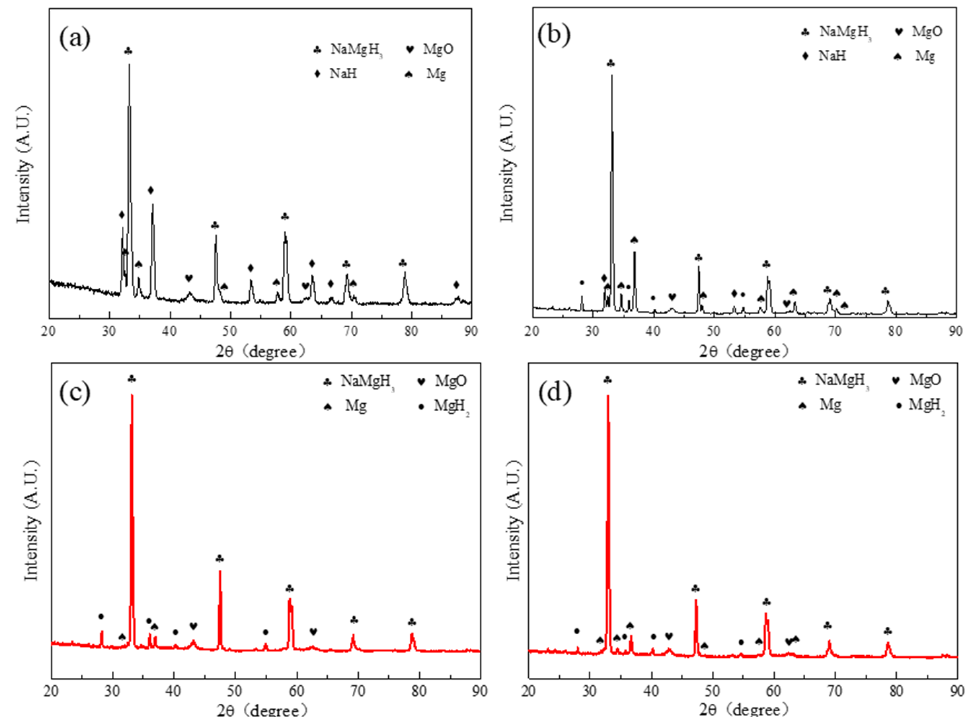
Figure 8. XRD patterns of pure NaMgH 3 before the ( a ) second and ( b ) third dehydrogenations at 400 °C. XRD patterns of NaMgH 3 -7 wt.% Ti 3 C 2 before the ( c ) second and ( d ) third dehydrogenations at 400 °C.